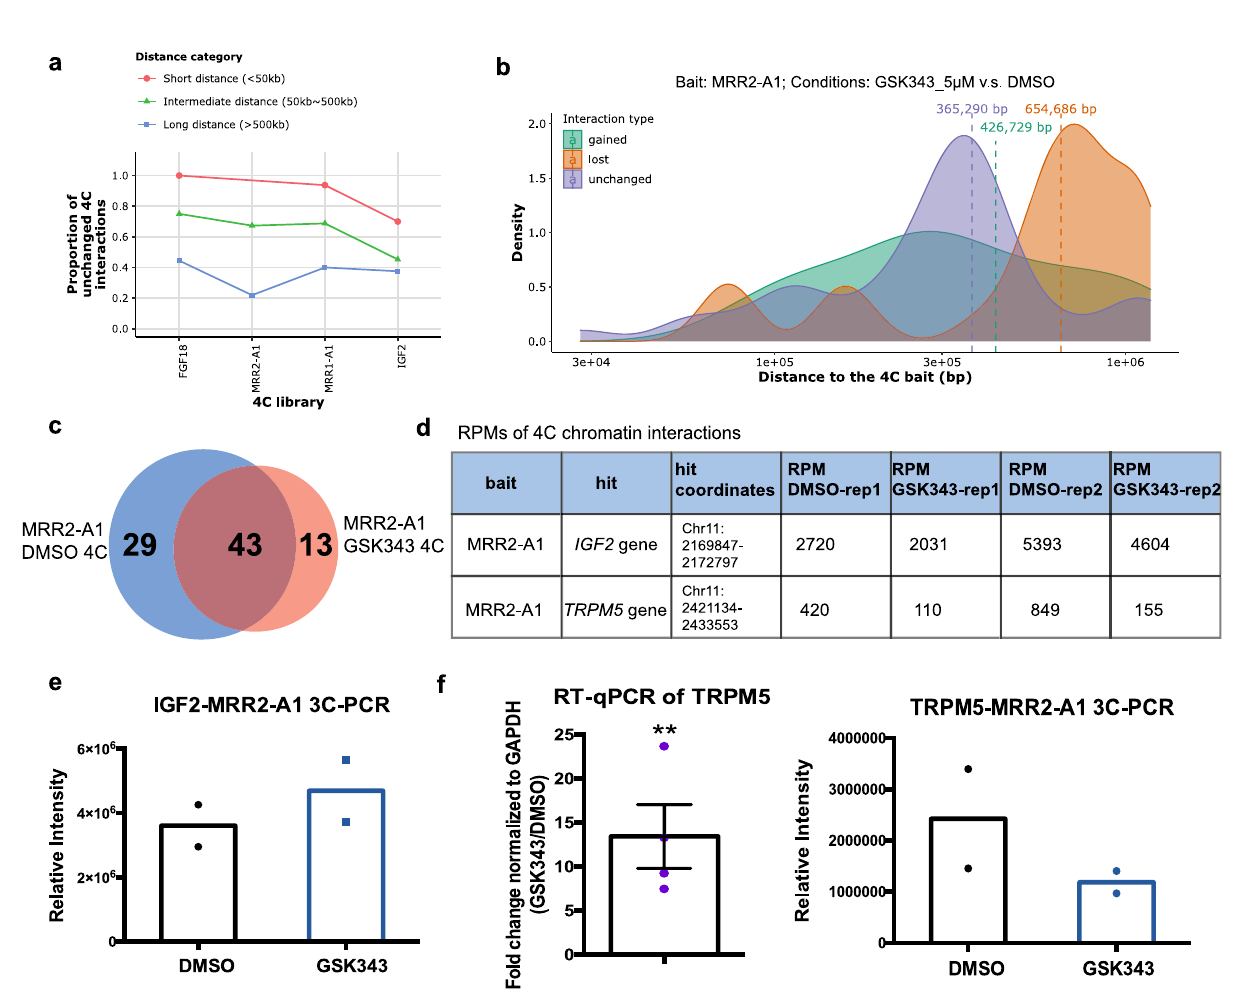
Fig. 9 Analysis of stable and changing chromatin interactions upon EZH2 inhibition. a Proportions of unchanged 4C interactions in different distance categories (short, intermediate and long) in 5 μ M GSK343-treated K562 cells. The bait name is used as the name of the 4C libraries. As the distance of 4C interactions increases, the proportion of unchanged 4C interactions drops, suggesting that long-range interactions are perturbed. b The average distance of changed loops (gained loops and lost loops) is greater than unchanged loops upon GSK343 treatment when using MRR2-A1 as the bait. c Venn diagram of 4C chromatin interactions using MRR2-A1 as the bait in DMSO and GSK343 condition. d Table of Reads Per Million (RPMs) of 4C chromatin interactions in two individual replicates. e 3C-PCR of IGF2 -MRR2-A1 loop in DMSO and GSK343 condition by two independent 3C libraries. The data are shown as relative intensity. f RT-qPCR of TRPM5 gene ( N = 4) and 3C-PCR of TRPM5 -MRR2-A1 in DMSO and GSK343 condition by two independent 3C libraries. All data shown here are average + standard error. P value is calculated by two-tailed student ’ s t -test. P value less than 0.01 is shown as **.